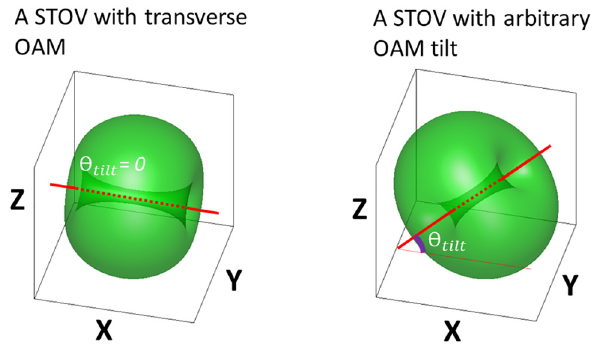
, left: a STOV tilt can tilt